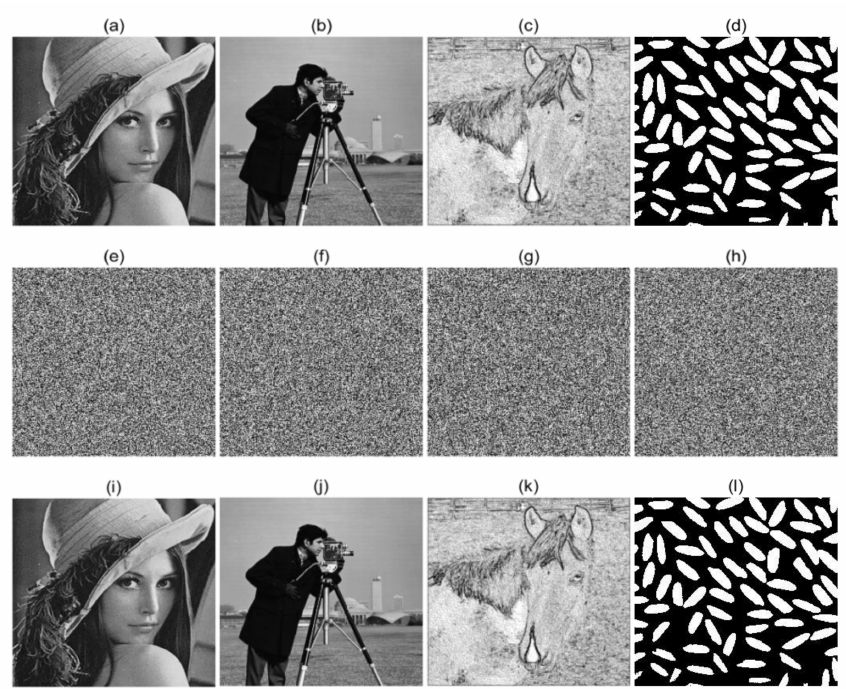
Figure 10. Encryption and decryption test ( a – d ). Original images; ( e – h ) encrypted images; ( i – l ) decrypted images.